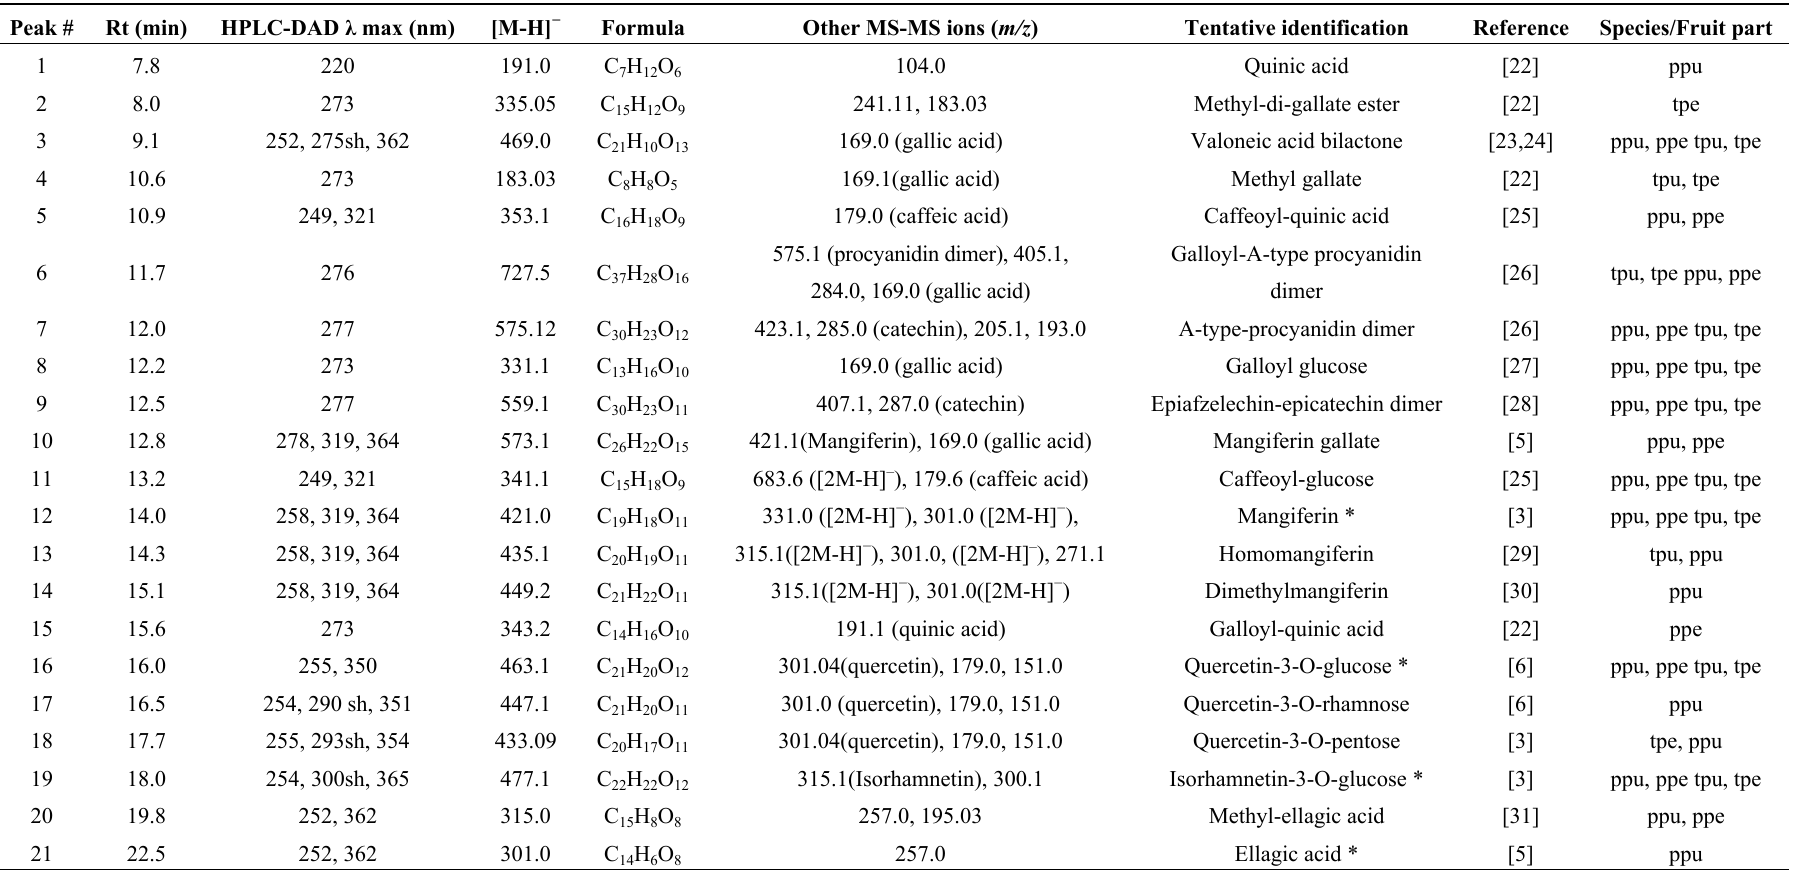
Table 1. Identification of phenolic compounds in mango pulp and peel by LC-PDA, LC–ESI-ToF-MS and MS/MS